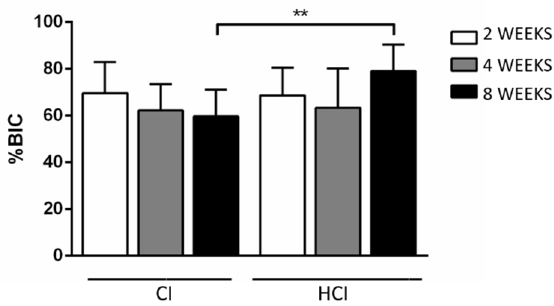
Figure 8. Mean and standard deviation for %BIC data obtained through histometric analysis of all groups. **p < 0.01—Differences between groups of implants with different macrostructures—Paired t-test. Table 3. Data on the mean and standard deviation for %BIC data obtained through histometric analysis of all groups.